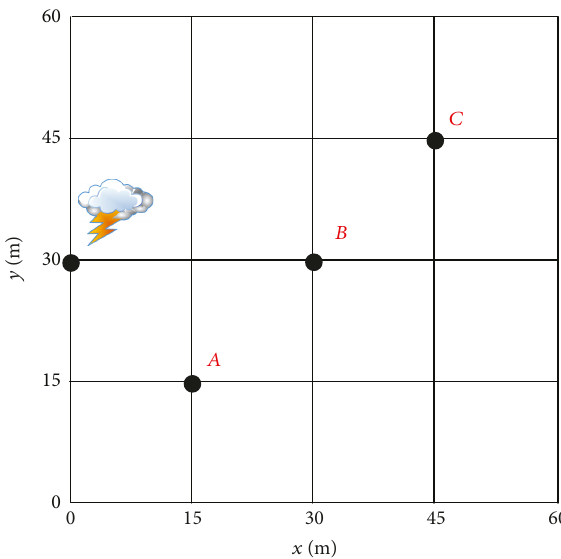
Figure 8: Three selected points for investigation of lightning e ff ect.